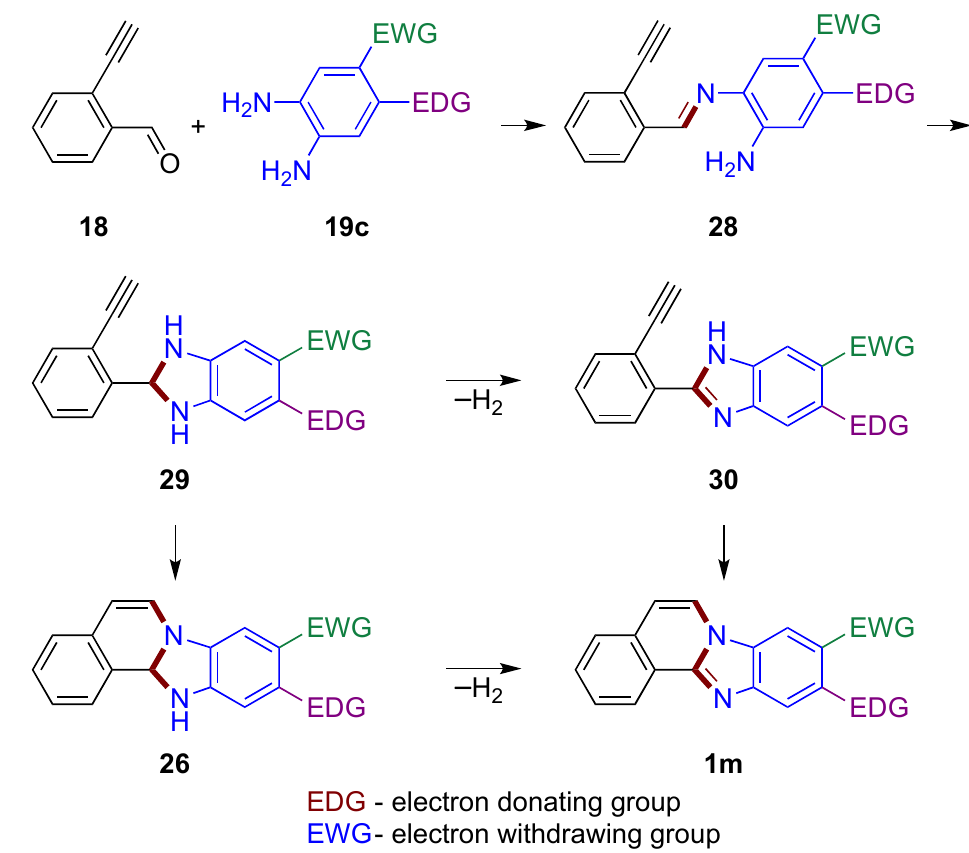
Figure 20. Mechanistic outline for the formation of benzimidazo[2,1- a ]isoquinolines 1m with carbonyl group reacting first, illustrating regioselectivity of a reaction using EDG- and EWG-substituted phenylenediamine.